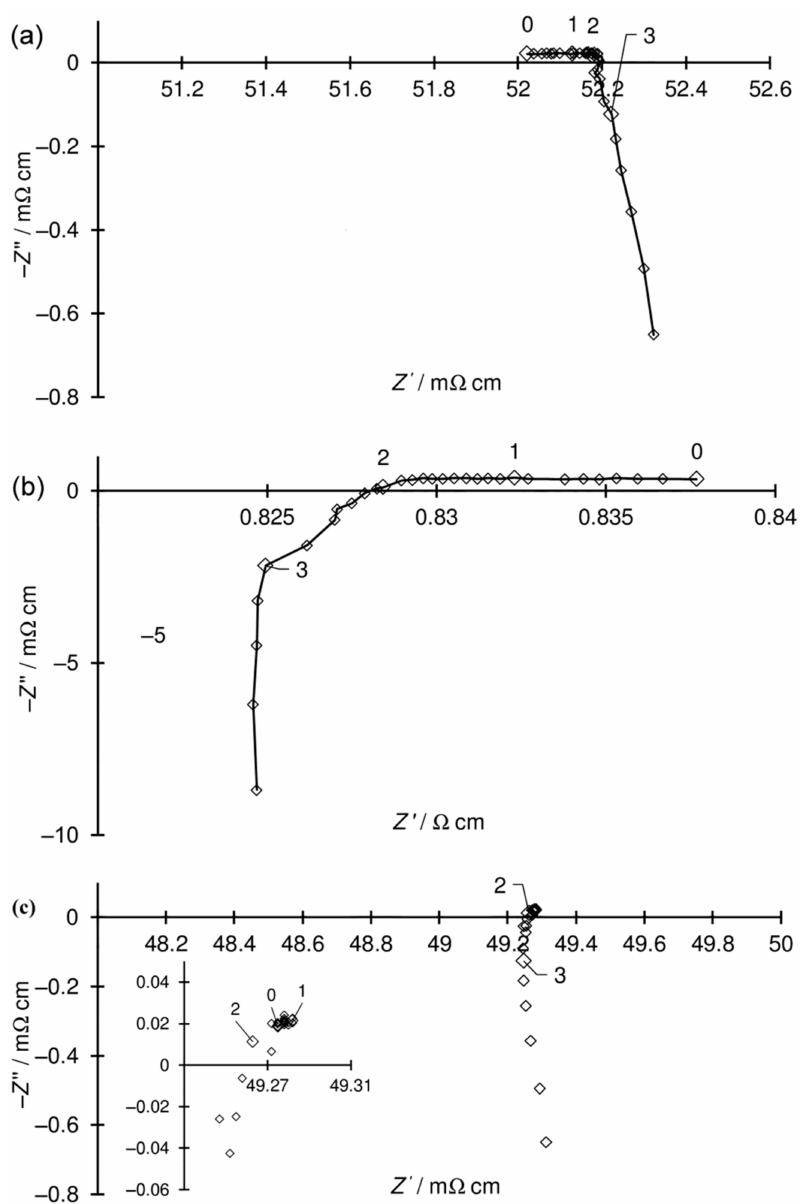
Figure 15. Examples of EIS spectra: ( a ) during reduction (decrease in impedance is visible); ( b ) during oxidation (increase in impedance is visible); ( c ) reduced sample (inset shows the enlarged capacitive part of the